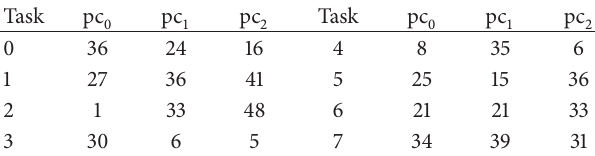
Table 3: Computation cost with VSL